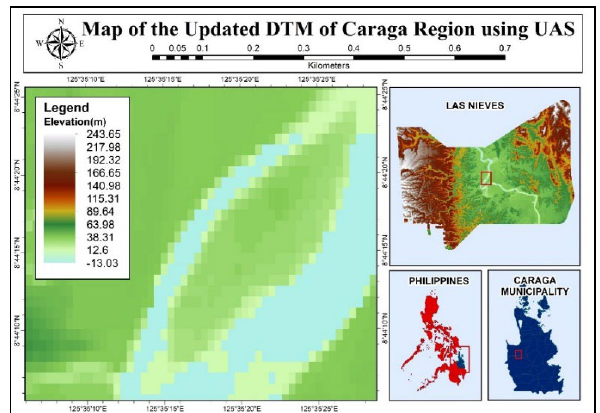
Figure 13 . Map of the Updated DTM of Caraga Region using UAS